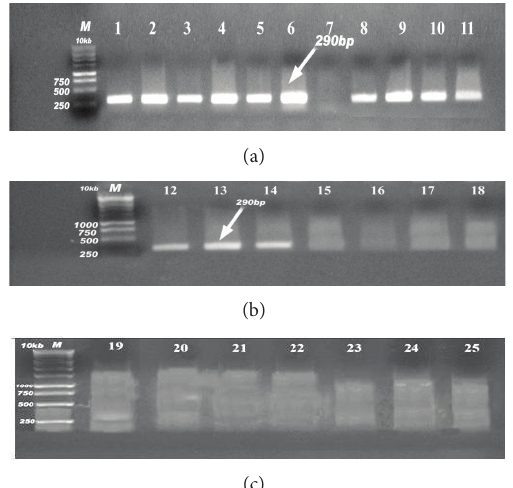
Figure 4: (a, b, c) Detection of iss gene in samples; positive samples produce band 290 bp; lane M: 1Kb DNA Ladder; lanes 1–6 and 8–14 were positive samples.